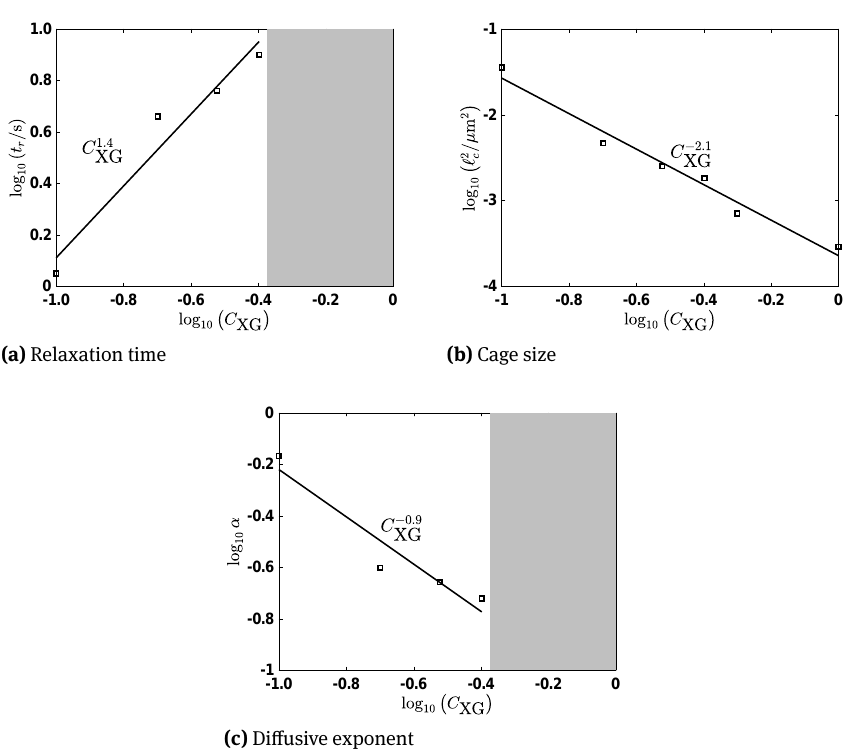
Figure 7: Diffusive properties as a function of the concentration of XG. (a) The relaxation time t r versus concentration. The relaxation time increases with the concentration of XG with the scaling of C 1.4 XG . The gray area shows that, at a concentration of 0.5% and higher, the parti- cles are permanently captured in elastic cages, and the relaxation time cannot be obtained. (b) The cage size ℓ c versus concentration. The cage size decreases with the concentration of XG with the scaling of C −2.07 XG . (c) The diffusive exponent α versus concentration. With an in- crease of the concentration of XG (from 0.1% to 0.4%), the motions of the particles become more subdiffusive, and the diffusive exponent, α , scales as C −0.92 XG . The gray area shows that, at a concentration of 0.5% and higher, the diffusive exponent is zero, and the ASM+XG mix- tures are purely elastic.